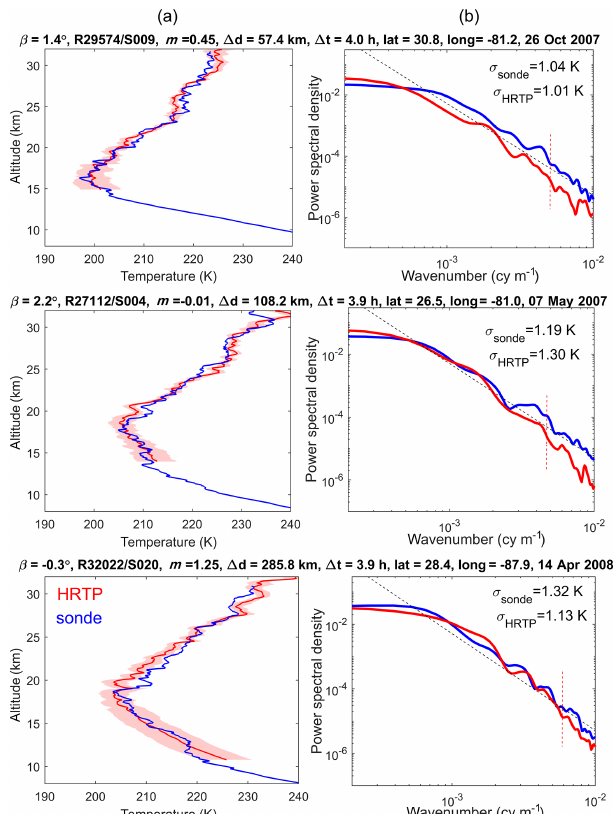
Figure 7. (a) Examples of HRTPs and collocated radiosonde pro- files for some full-dark vertical occultations of very bright stars: (b) power spectral densities for these profiles, for the altitude range 18–30km. Dashed black lines show the spectra corresponding to the saturated gravity wave model with the slope of − 3 (Smith et al., 1987). Information about GOMOS measurements, obliquity an- gles β , star magnitude m , spatial (cid:49)d and temporal (cid:49)t separation, as well as the values of rms fluctuations are specified above each panel. Red dashed vertical lines in right-hand panels indicate the small-scale regions where HRTP resolution can affect the spectra.